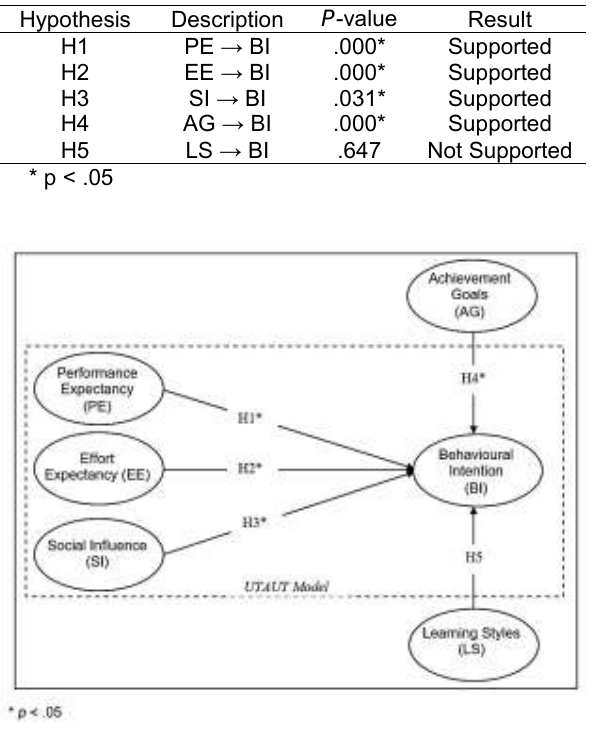
Figure 3. Final Research Model